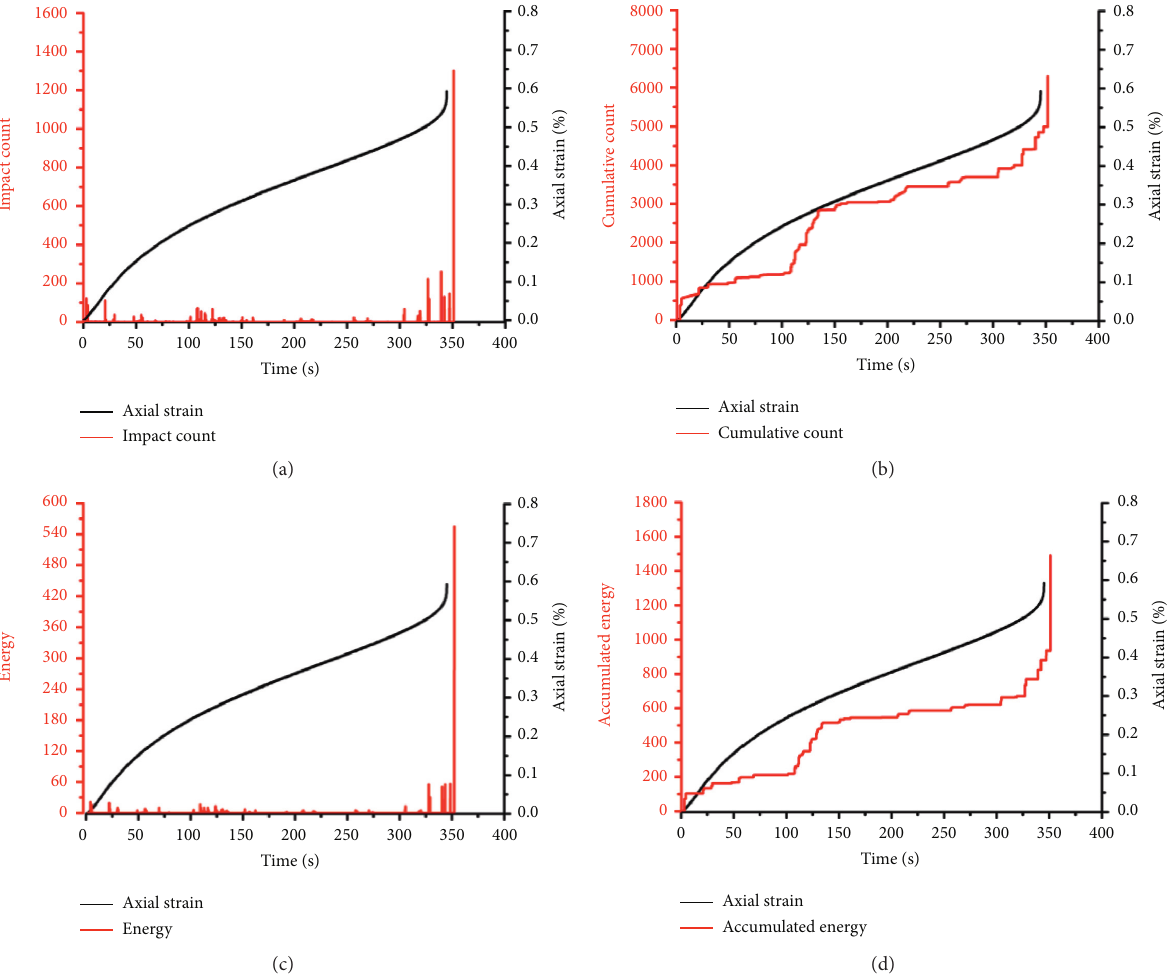
Figure 10: Deformation and acoustic emission characteristics of C-100-1 sample. (a) The curves of ringing count and axial strain of C-100-1 sample with time. (b) The curves of cumulative ringing count and axial strain of C-100-1 sample with time. (c) The curves of energy and axial strain of C-100-1 sample with time. (d) The curves of cumulative energy and axial strain of C-100-1 sample with time.